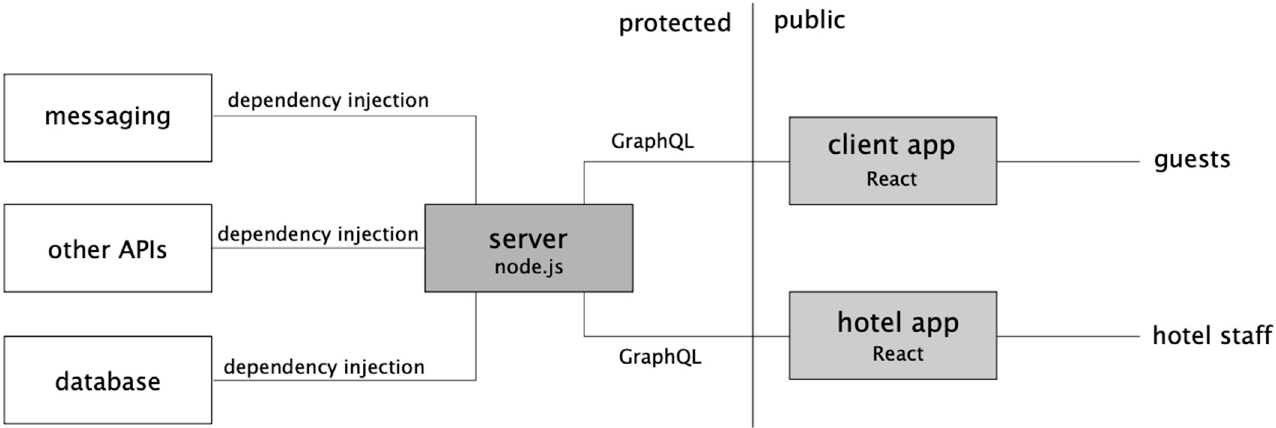
Figure 6. The architecture of the software.